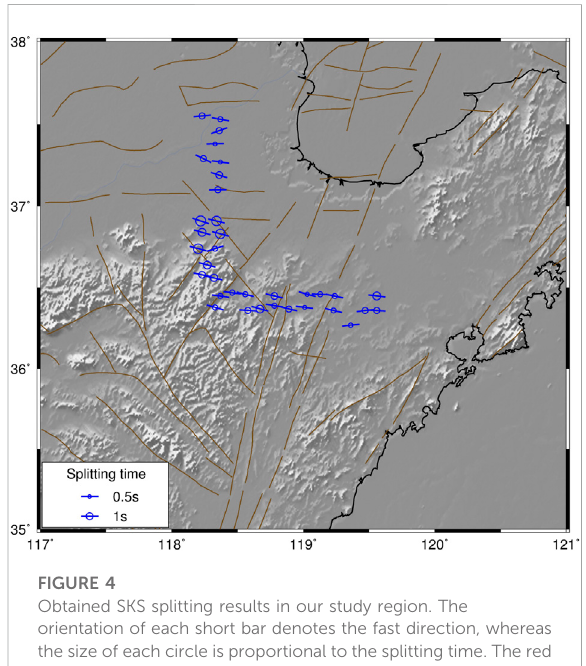
FIGURE 4 Obtained SKS splitting results in our study region. The orientation of each short bar denotes the fast direction, whereas the size of each circle is proportional to the splitting time. The red lines denote major active faults (Deng et al.,